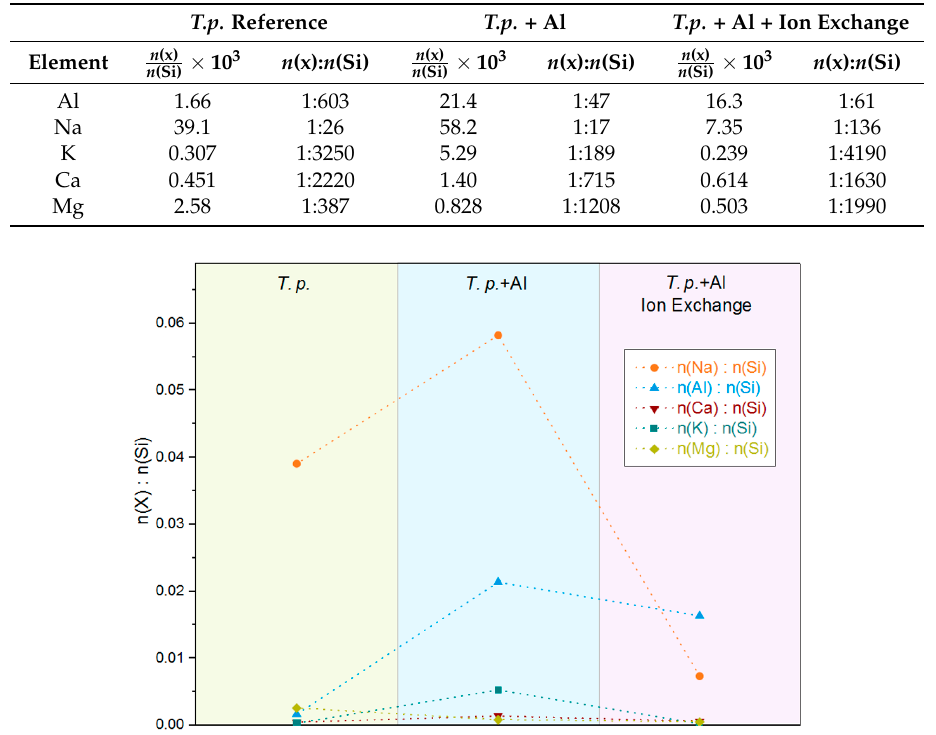
Figure 3. Molar ratios of several elements to Si in the biosilica of T.p. cultured in standard ASW ( T.p. Reference) as well as T.p. cultured in artificial seawater (ASW) enriched with aluminum, calcined only ( T.p. + Al) and with additional ion exchange ( T.p. + Al Ion Exchange); dashed lines to connect ratios of the same elements.